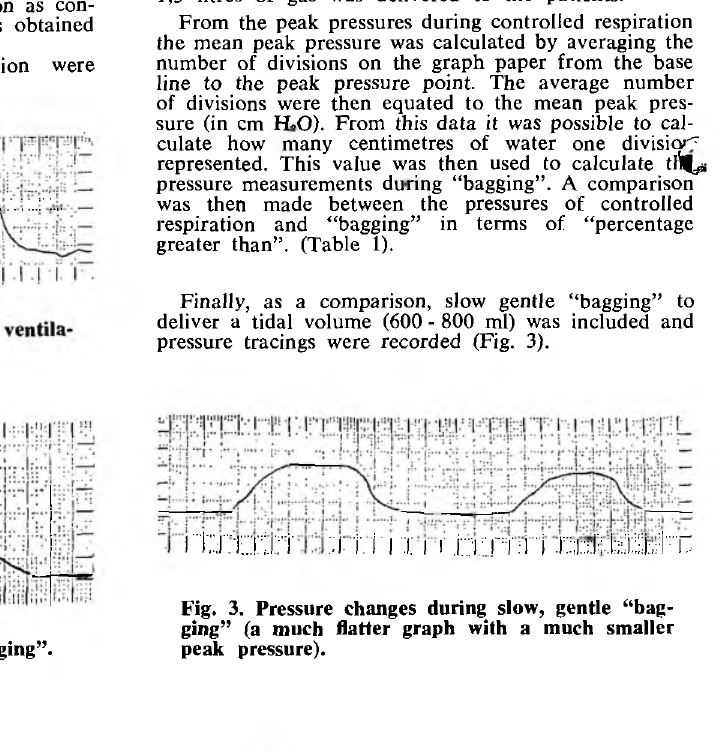
Fig. 2. Pressure changes during “bagging”.